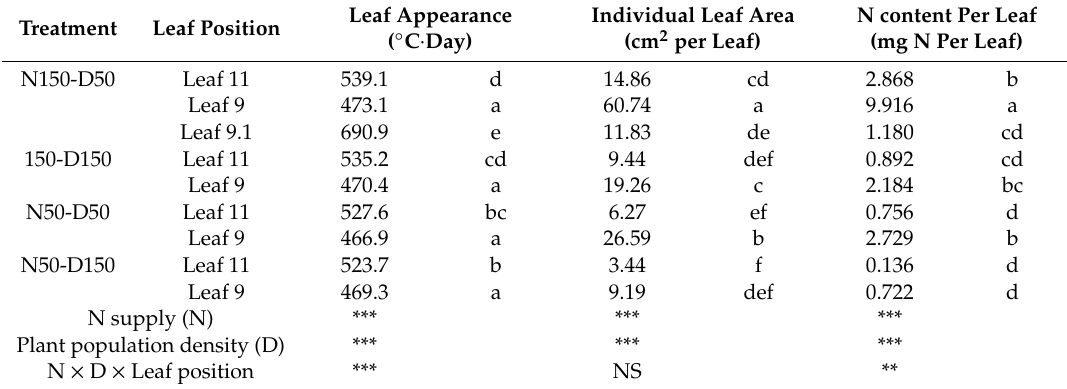
Table 2. Time of appearance, leaf area, and N content of leaves at phytomers 9, 9.1, and 11. Treatment Leaf